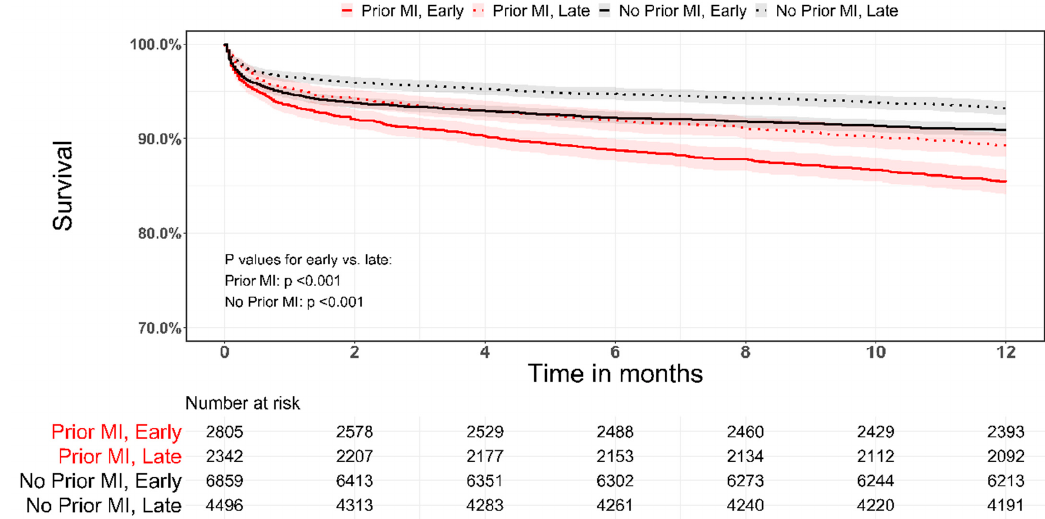
Table 4. Clinical outcomes of patients with and without prior MI between time periods (early 2000–2008 vs. late 2010– 2018) after propensity score matching.